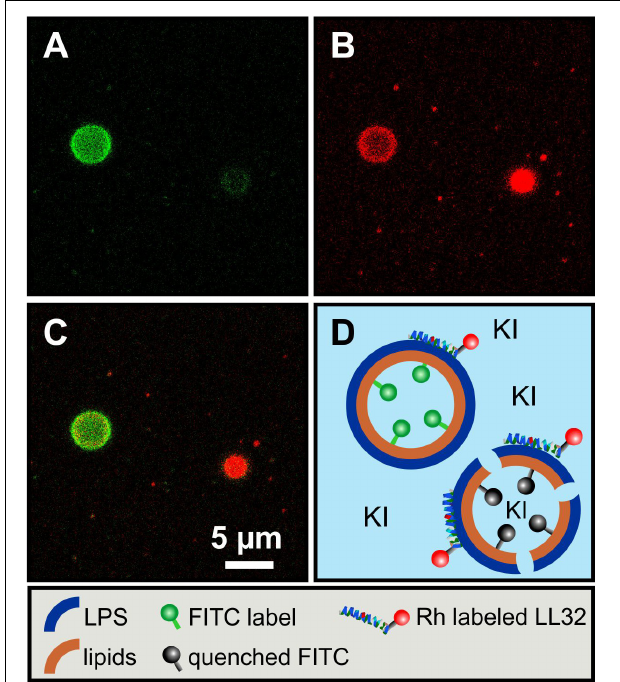
FIGURE 7 | Fluorescence quenching in asymmetric LPS R45/PL vesicles allows the observation of a concentration dependent permeabilization by antimicrobial peptide LL-32. For fluorescent labeling of the vesicles 2% (w/w) of the PL (PE:PG:CL; 81:17:2; w/w/w) in the inner leaflet were fluorescent FITC-PE. Images show the vesicles after incubation with 0.83 M KI and 38 nM Rho LL32. (A) FITC-PE fluorescence; (B) Rho LL-32 fluorescence; (C) Superposition of (A) and (B) ; (D) Illustration of the experiment. The left vesicle had taken up less Rho LL-32, remained intact and therefore exhibited unquenched FITC fluorescence from its inner leaflet. The right vesicle had taken up more Rho LL-32, was permeabilized and partly quenched by invading KI. Experiments were carried out at 25 ◦ C in 100 mM KCl, 5 mM MgCl 2 , 5 mM HEPES at pH 7.0 using a Leica TCS SP3 confocal microscope. Scale bar applies for (A–C)